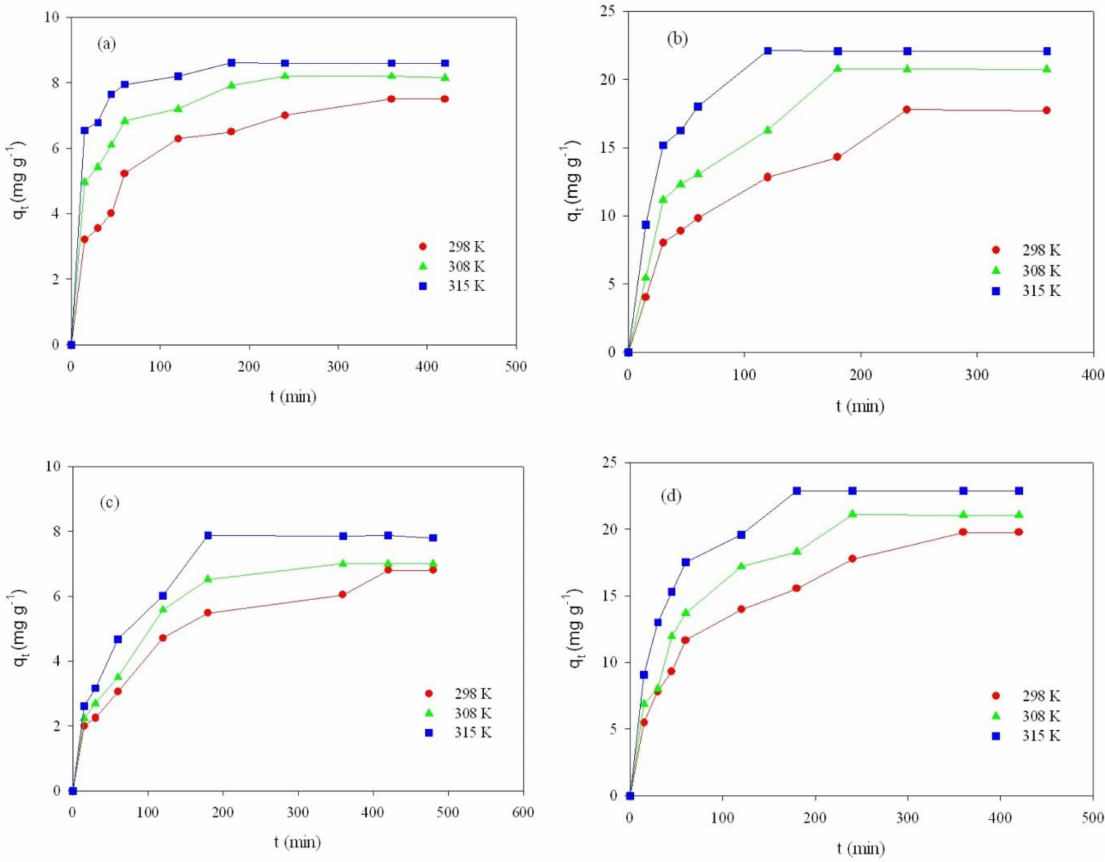
Figure 8. Effect of contact time on adsorption of RB on ST-A ( a ) and CWZ-22 ( c ), and adsorption of AY17 on ST-A ( b ) and CWZ-22 ( d ) at 298, 308, and 315